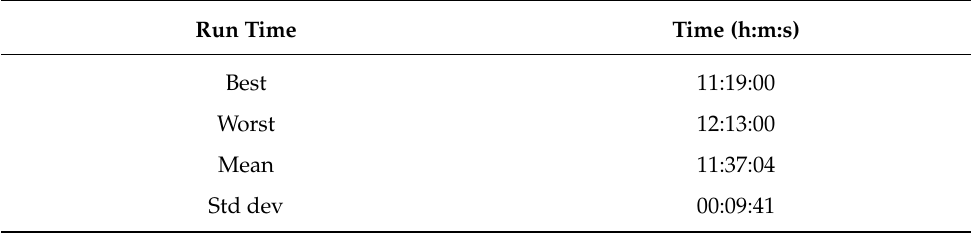
Table 9. Experiments measures: running time for Scenario Scenario A4—Random.